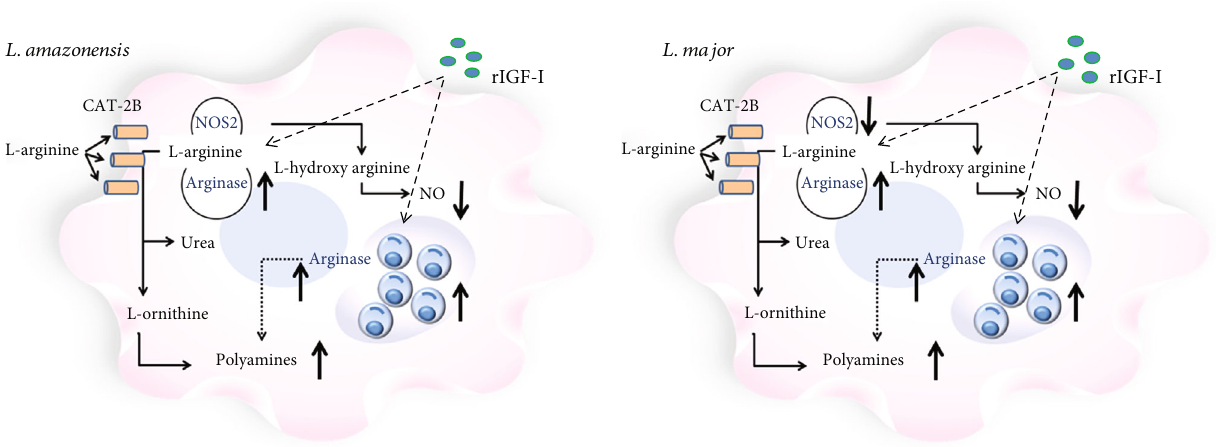
Figure 2: Scheme of the e ff ect of extrinsic IGF-I (rIGF-I) in the L-arginine metabolic pathway activation in macrophages infected by L. amazonensis and L. major . In RAW 264.7 cells or BALB/c mouse peritoneal macrophages infected with L. amazonensis or L. major promastigotes and stimulated with 50 ng/mL recombinant IGF-I (rIGF-I, R&D Systems, USA), the parasitism, arginase mRNA expression, and arginase activity, nitric oxide synthase 2 (NOS2) mRNA expression, and nitric oxide production (Griess reaction) were evaluated. Extrinsic IGF-I induced an increase in arginase expression and arginase activity in both parasites and macrophages, decreased the production of NO, and increased the parasitism in L. amazonensis - and L. major -infected cells,